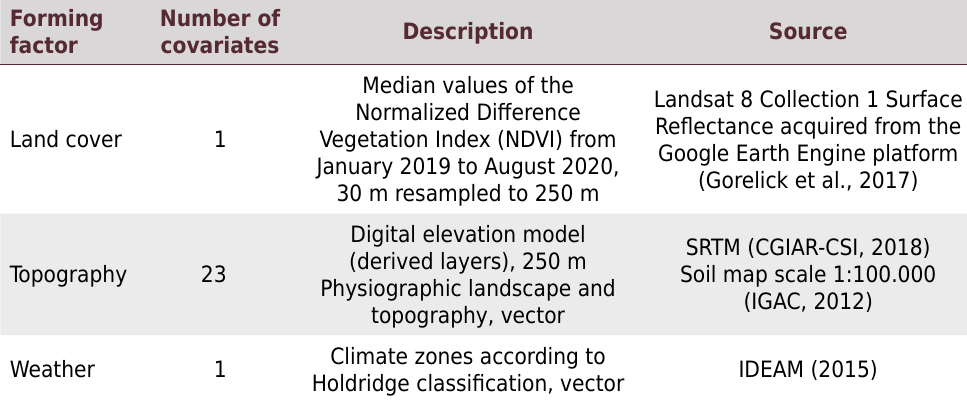
Table 1. Auxiliary layers for modeling soil properties in the study area